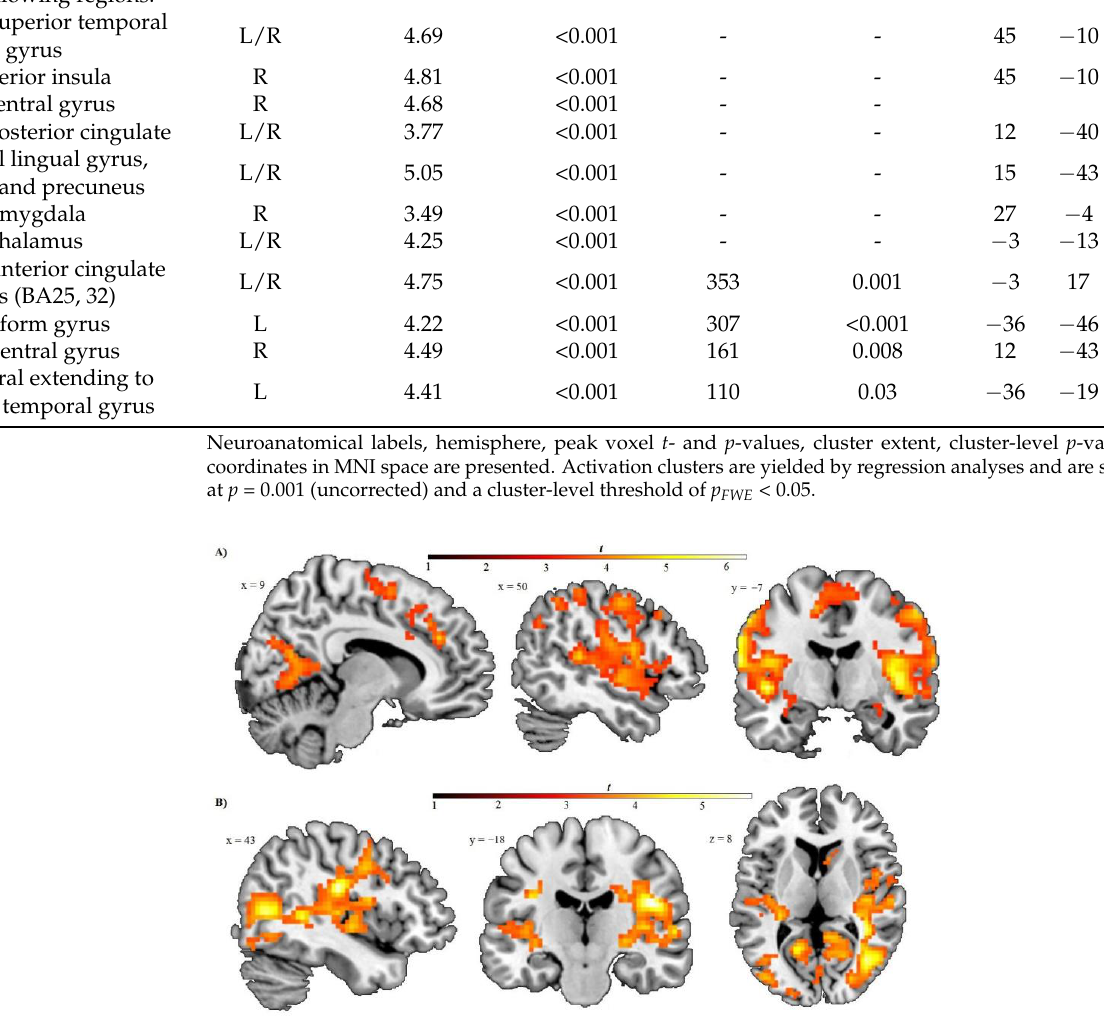
Figure 2. Results from whole-brain regression analyses with cognitive avoidance predicting decreased brain responsiveness to contemptuous and fearful faces under high load. ( A ) Sagittal and coronal images in neurological orientation showing the negative relationship between cognitive avoidance and responsivity to contemptuous (vs. neutral) faces under high perceptual load. Depicted are activation clusters in the right superior medial frontal and cingulate gyrus (BA32), supplemental motor area (BA6), precuneus, cuneus, and lingual gyrus (top left), in the right precentral (BA4), inferior frontal gyrus, and parietal and superior temporal lobes (top middle), and in the insula, postcentral gyrus, superior temporal gyrus, left amygdala, and supplementary motor area (top right). ( B ) Sagittal, coronal, and axial images showing the negative correlation between cognitive avoidance and activation in response to fearful (vs. neutral) faces under high perceptual load. Depicted are activation clusters in the precentral, supramarginal, and superior temporal gyrus (lower left), in the insula, subcentral gyrus, and superior temporal gyrus (lower middle), and in the posterior insula, superior temporal gyrus, calcarine, and middle occipital gyrus (lower right). The voxel-wise threshold was set to p = 0.001 (uncorrected) with a cluster-level threshold of p < 0.05, FWE-corrected. Color bar: t -values.